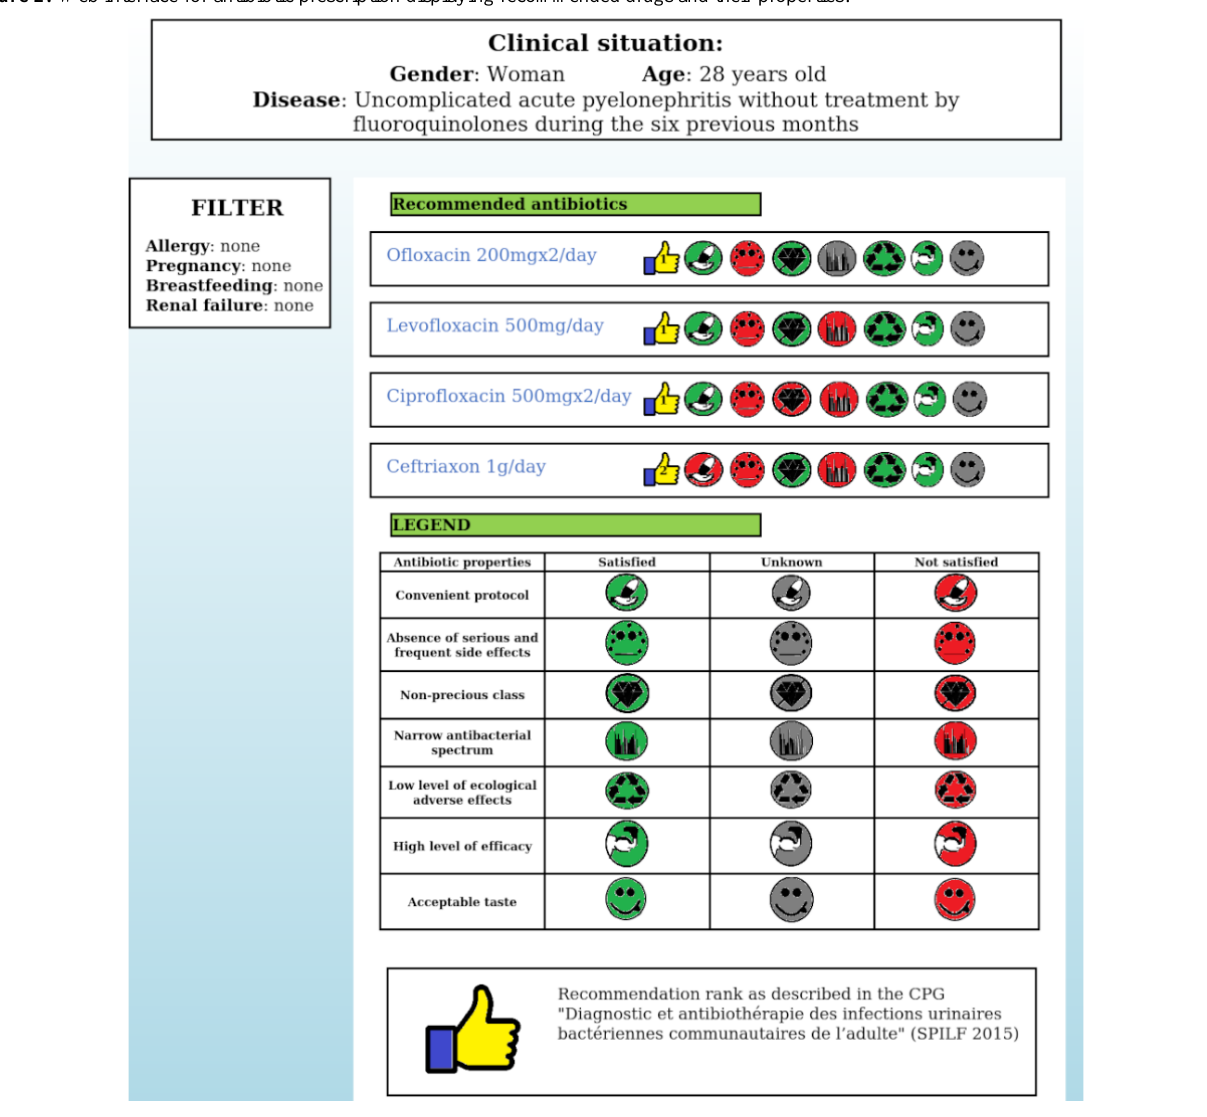
Figure 2. Web interface for antibiotic prescription displaying recommended drugs and their